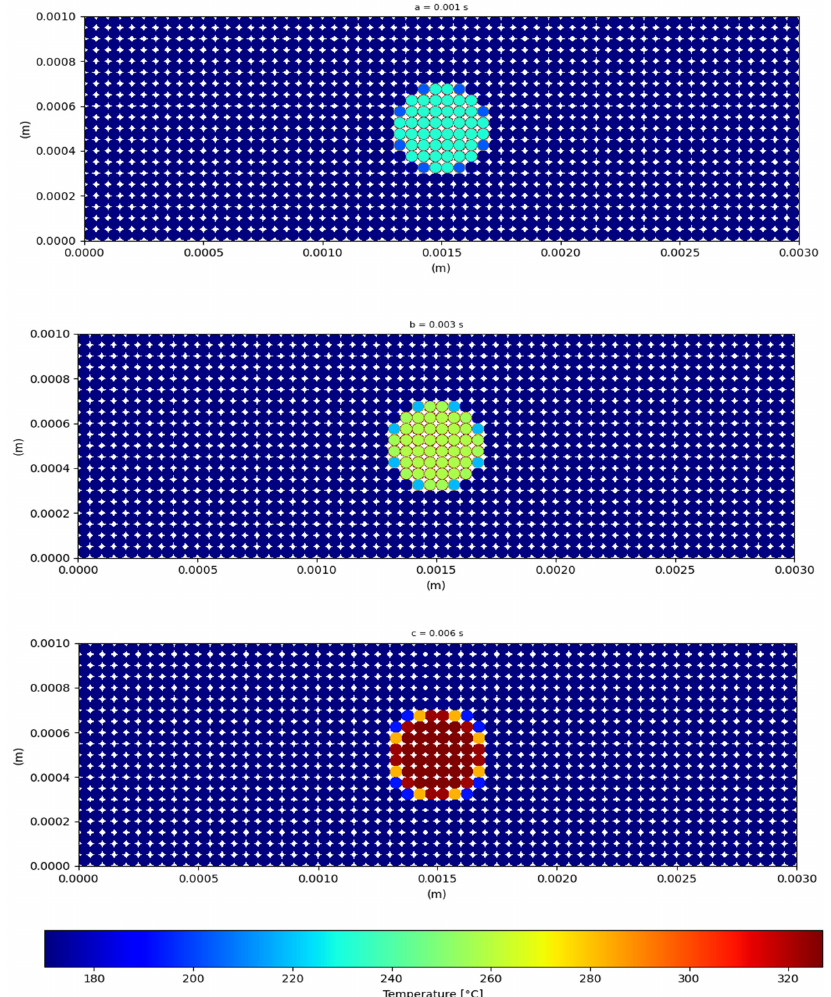
Figure 12. Visualization of the temperature in the powder bed under the effect of a stationary laser at three different times (a = 0.001 s, b = 0.003 s, c = 0.006 s).